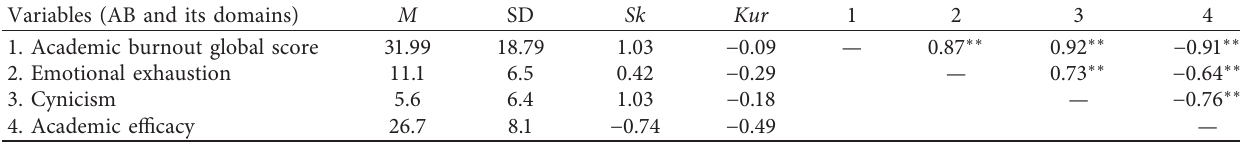
Table 1: Descriptive statistics and correlation analyses for academic burnout.